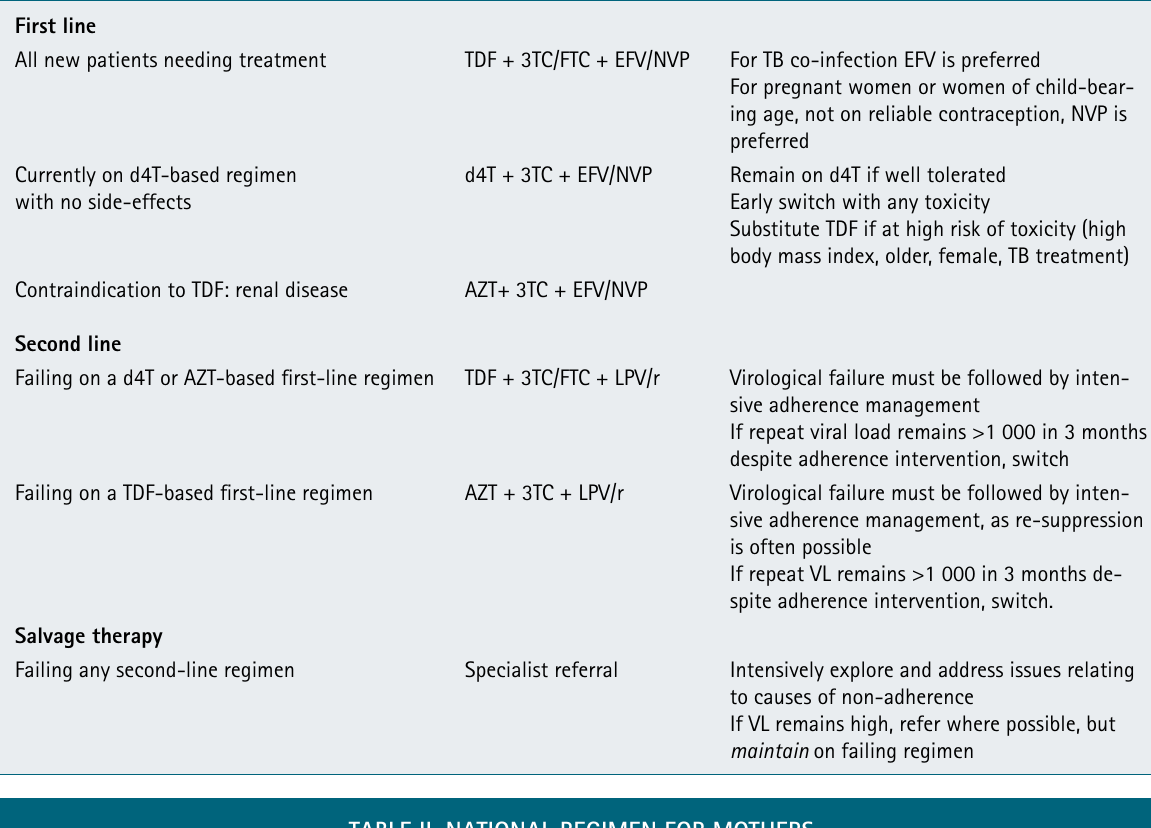
TABle ii. nATiOnAl RegiMen FOR MOTHeRs